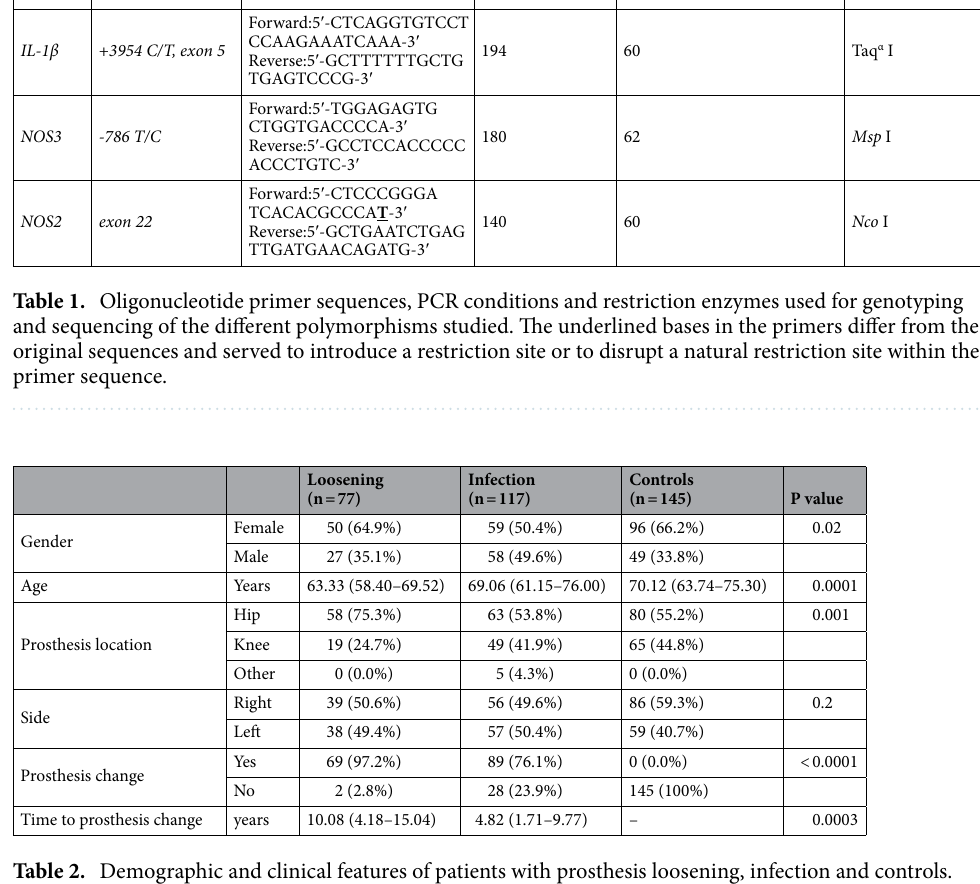
Table 2. Demographic and clinical features of patients with prosthesis loosening, infection and